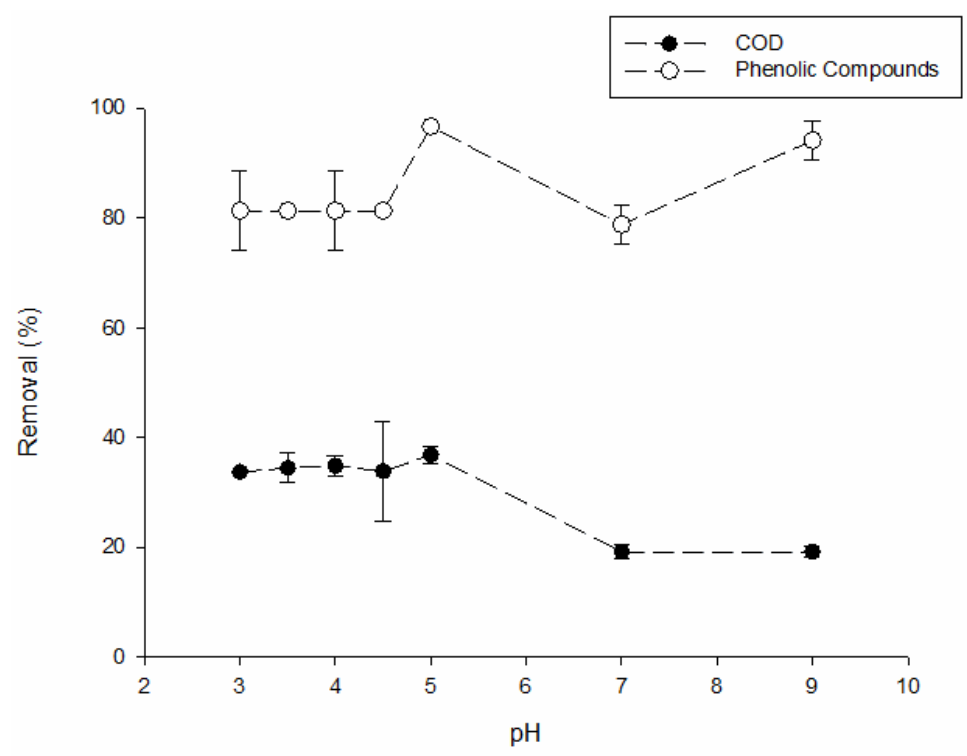
Figure 1. Initial pH influence on phenolic compounds and COD removal ([Fe 2+ ] = 300 mg/L, [PMS] = 1000 mg/L after 30 min of reaction) .